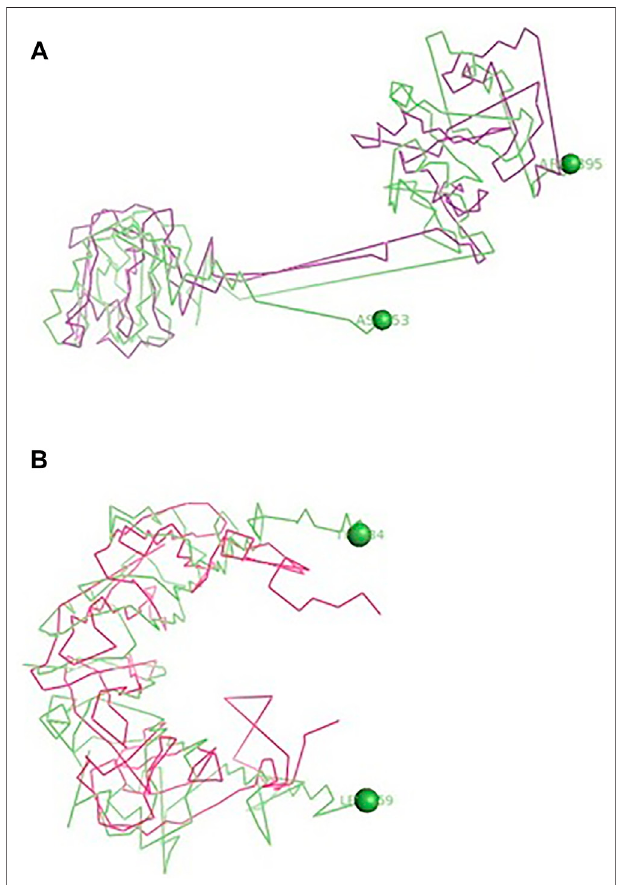
FIGURE6|(A) Moleculardocking-TLR3ofduckwithHantigenofAvian in fl uenza (B) Molecular docking TLR3 of duck with NS antigen of Avian in fl uenza.